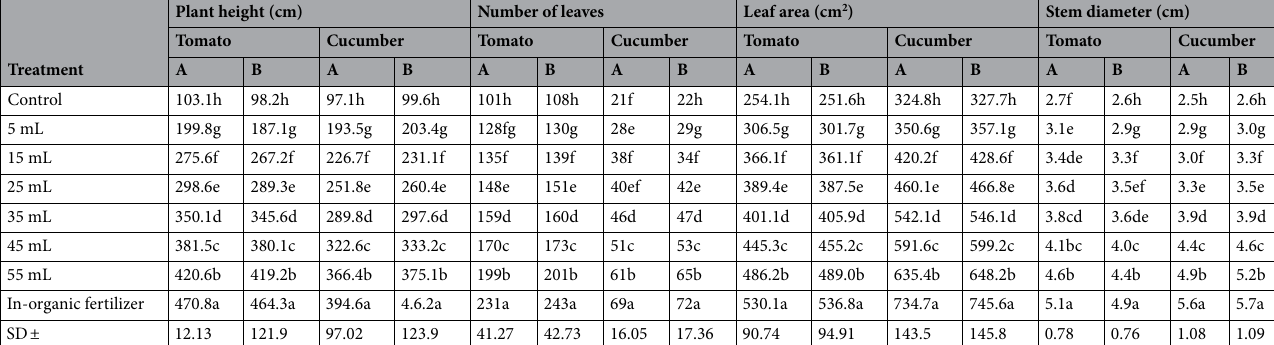
Table 1. Effect of organic and in-organic fertilizers of growth parameters of tomato and cucumber under soilless medium. Values followed by similar letters under the same column are not significantly different at p = 0.05 according to Duncan’s multiple range